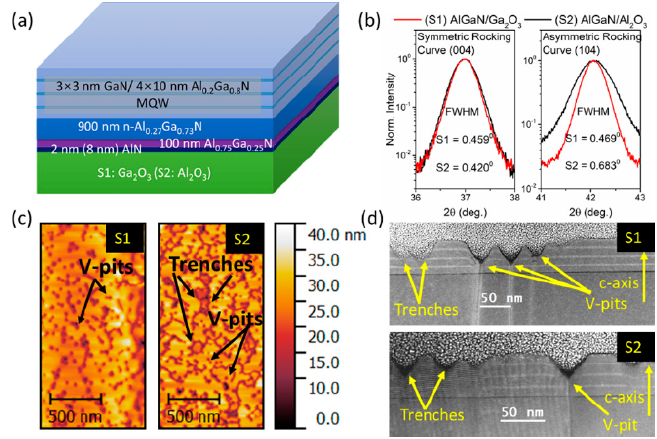
Figure 13. ( a ) Structural schematic of the samples. ( b ) Symmetric (0 0 4) and skew symmetric (1 0 4)